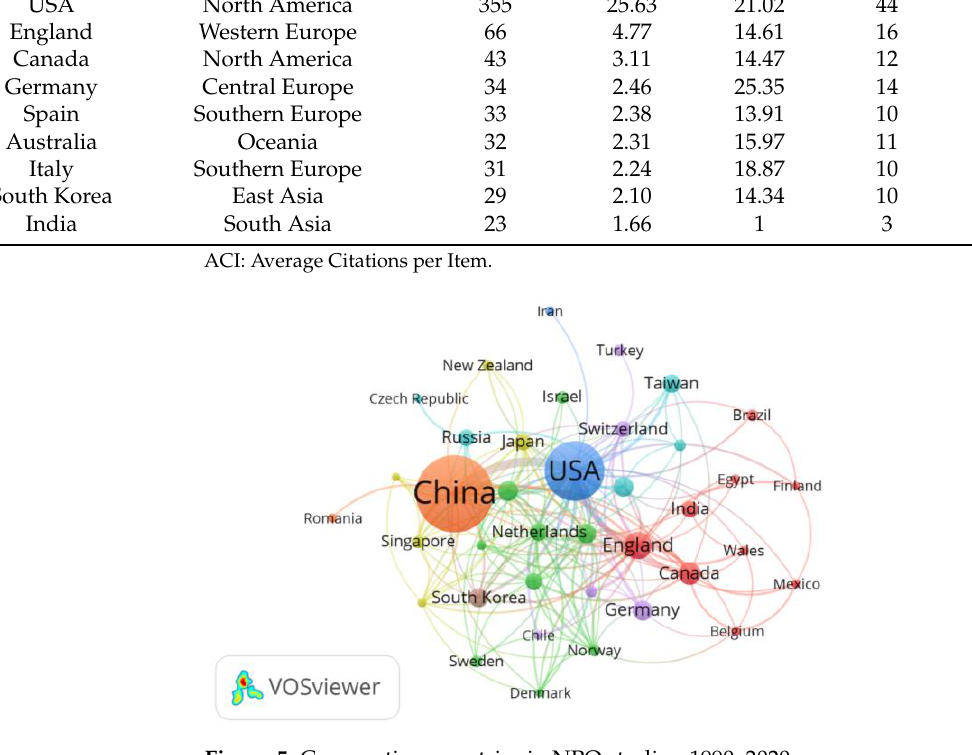
Figure 5. Cooperation countries in NPO studies, 1990 –